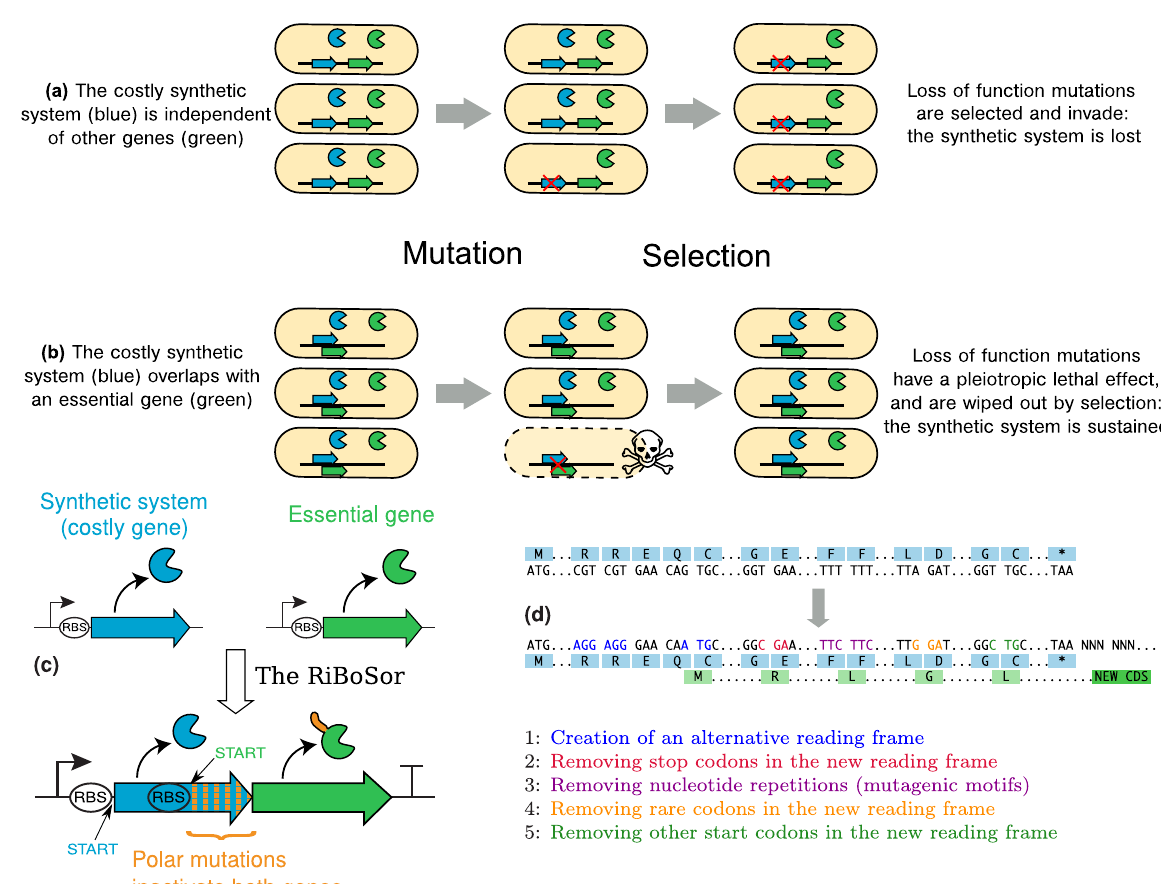
Fig 1. Principle and construction of a Riboverlap. (a) Standard case: loss-of-function mutations in the synthetic circuits are selected, because they alleviate the cost of the system. (b) The synthetic gene overlaps with an essential gene: loss-of-function mutations are discarded by natural selection because they induce a lethal cost. (c) Rational design of a Riboverlap: a new reading frame is created within the gene to protect (blue). An essential gene (green) is cloned downstream, within this reading frame. The CDS of this essential gene is entirely downstream of the pre- existing gene, however the translation initiation motif and thus the beginning of the reading frame lies within the pre-existing gene. The overlapping part (orange) is fused on the 5’ end of the essential protein. (d) Examples of synonymous changes made by the algorithm.